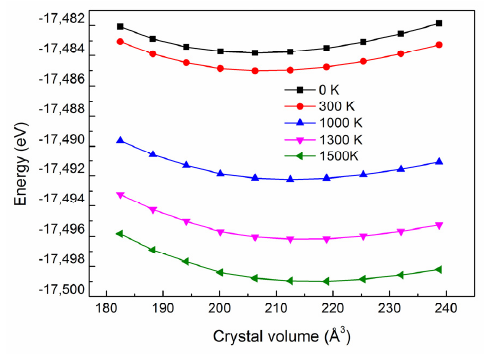
Figure 5. Dependence of the Helmholtz free energy E ( V , T ) on the crystal volume of AlNi 2 Ti under different temperatures.